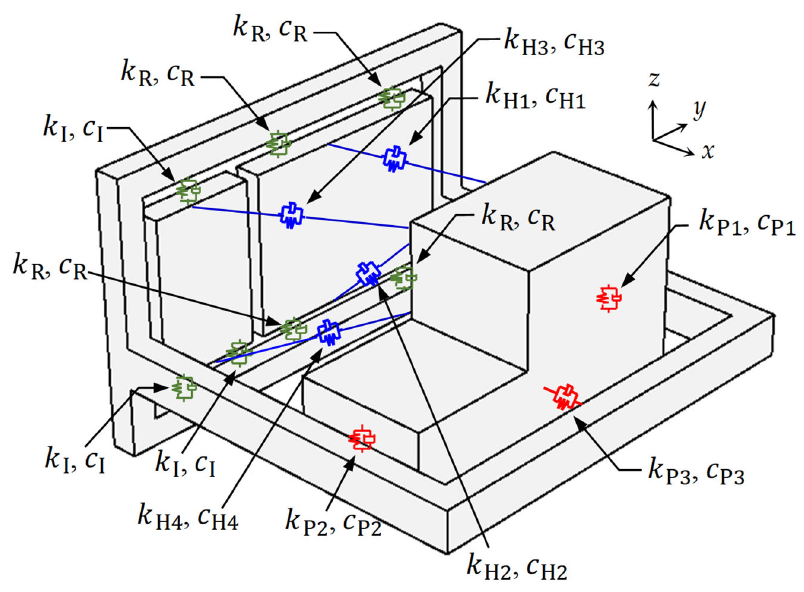
Figure 10. Equivalent stiffnesses and damping coefficients between the powertrain, radiator, inter-